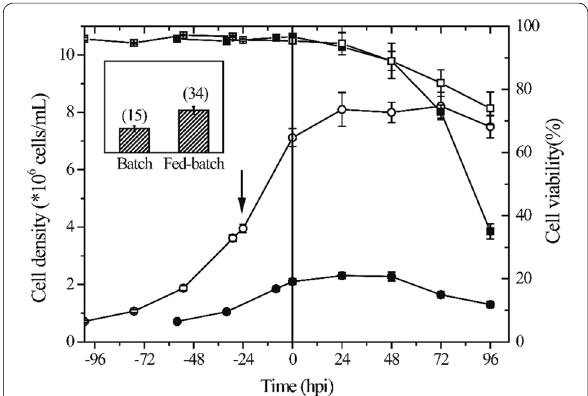
Fig. 3 Cell growth profile and PCV2-VLPs production of the infected Sf9 cells from fed-batch and control batch cultures in shake-flask experiments. For the fed-batch cultures, sf9 cells were infected by the baculovirus Ac- orf2 , at approximately 7 The feed was added when the cell density was 4.0 at the time of infection, as shown by the solid vertical arrows. Closed and open symbols represent the batch and fed-batch cultures, respectively; total cells (circle), cell viability (squares). The insert shows the volumetric PCV2-VLPs production expressed in mg/L for batch and fed-batch cultures after 96 hpi. Data represents the average of three independent experiments. Error bars represent standard deviation